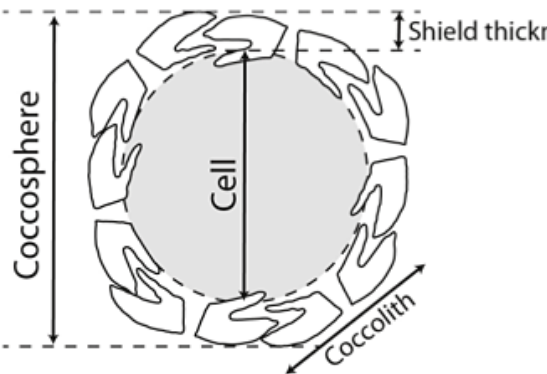
Figure 1. Schematic representation of a coccolithophore cell sur- rounded by a shield of coccoliths. The coccolith-bearing cell is called the coccosphere (modified from Hendericks,